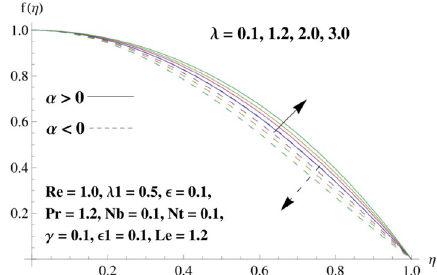
Figure 6. Behavior of f (η) against (cid:31) .